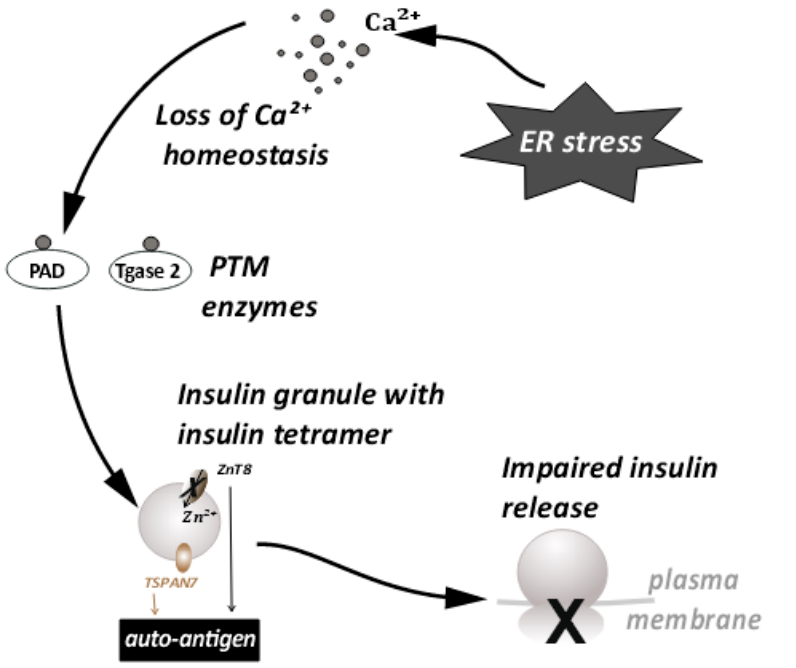
Figure 4. ER stress disturbs the Ca ++ ion homeostasis. This leads to the conversion of proteins important for insulin granule processing and release into autoantigens. This further leads to impaired insulin release.